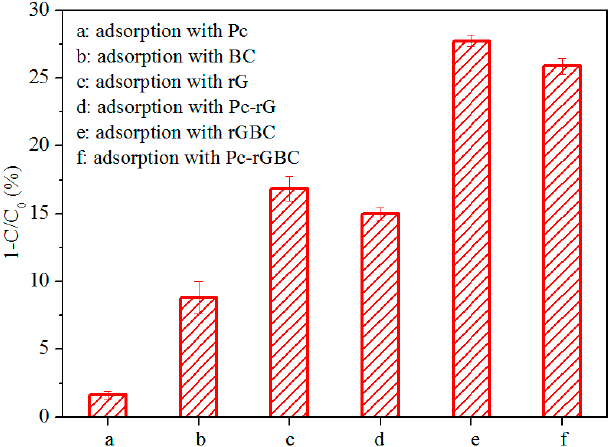
Figure 4. Comparison chart of phenol concentration change adsorbed by a: Pc; b: BC; c: rG; d: Pc-rG; e: rGBC; and f: Pc-rGBC. Initial phenol concentration = 100 mg/L; T = 50 °C; adsorption time = 180 min.